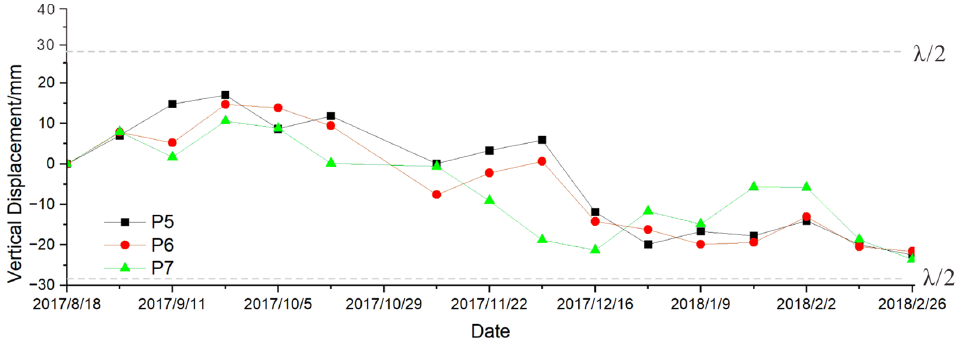
Figure 17. Time series deformation diagram of sampling points in region 2. The gray dotted lines are ambiguity (wavelength/2).